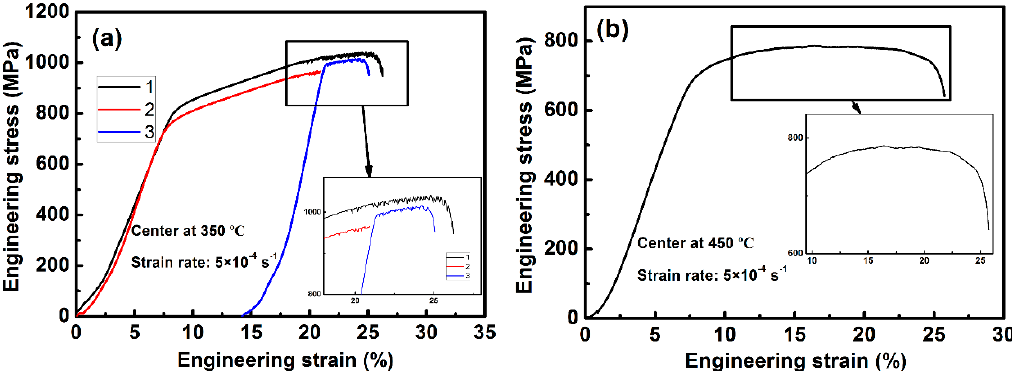
Figure 3. Tensile curves of the center sample at ( a ) 350 °C (curve 1: tensile curve; curve 2: loaded curve before the critical strain of the serrated flow; curve 3: reloaded curve) and ( b ) 450 °C.